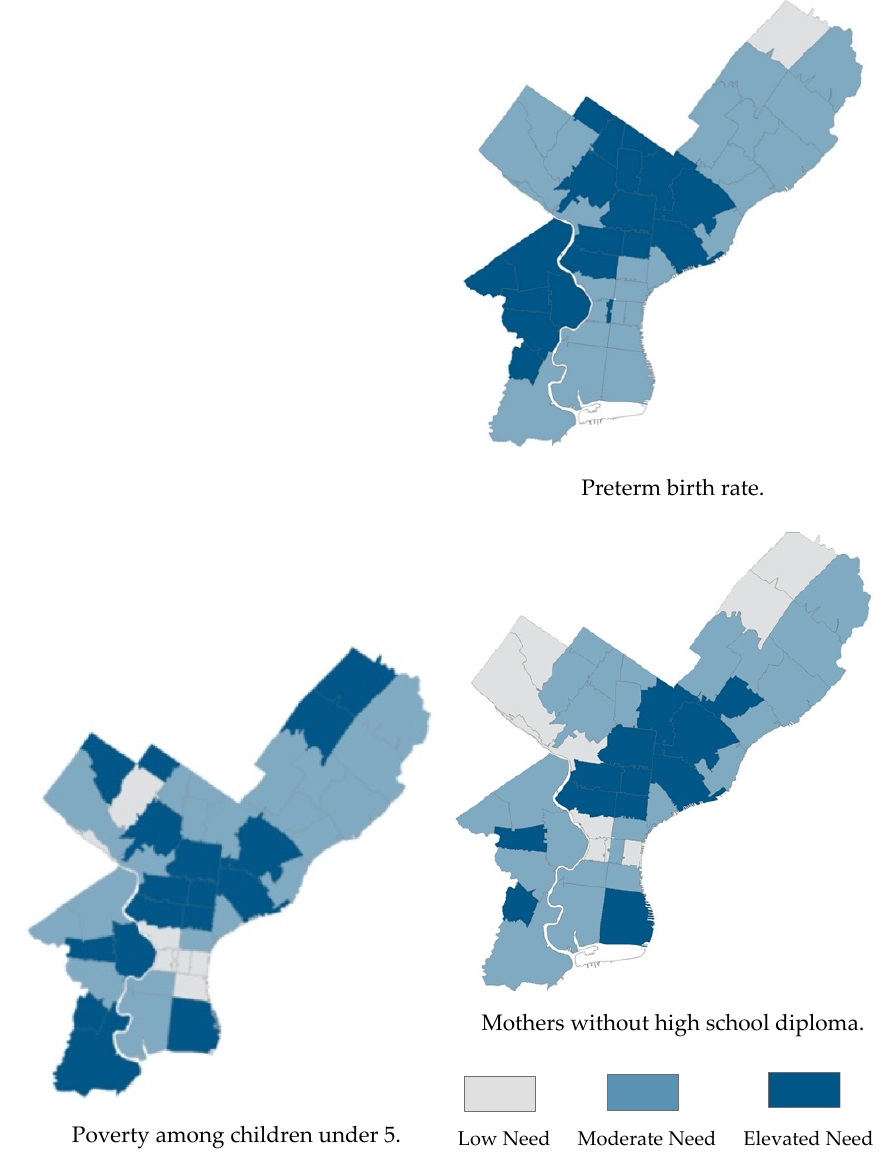
Figure 2. Zip-code level need indices, using Philadelphia County, PA, as an example.